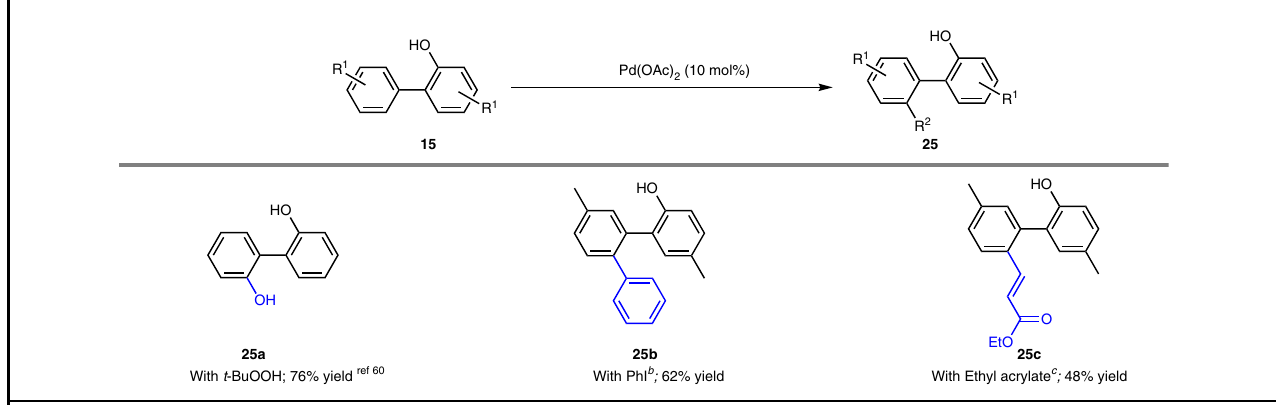
Table 4 Hydroxyl-directed C – H bond activation.